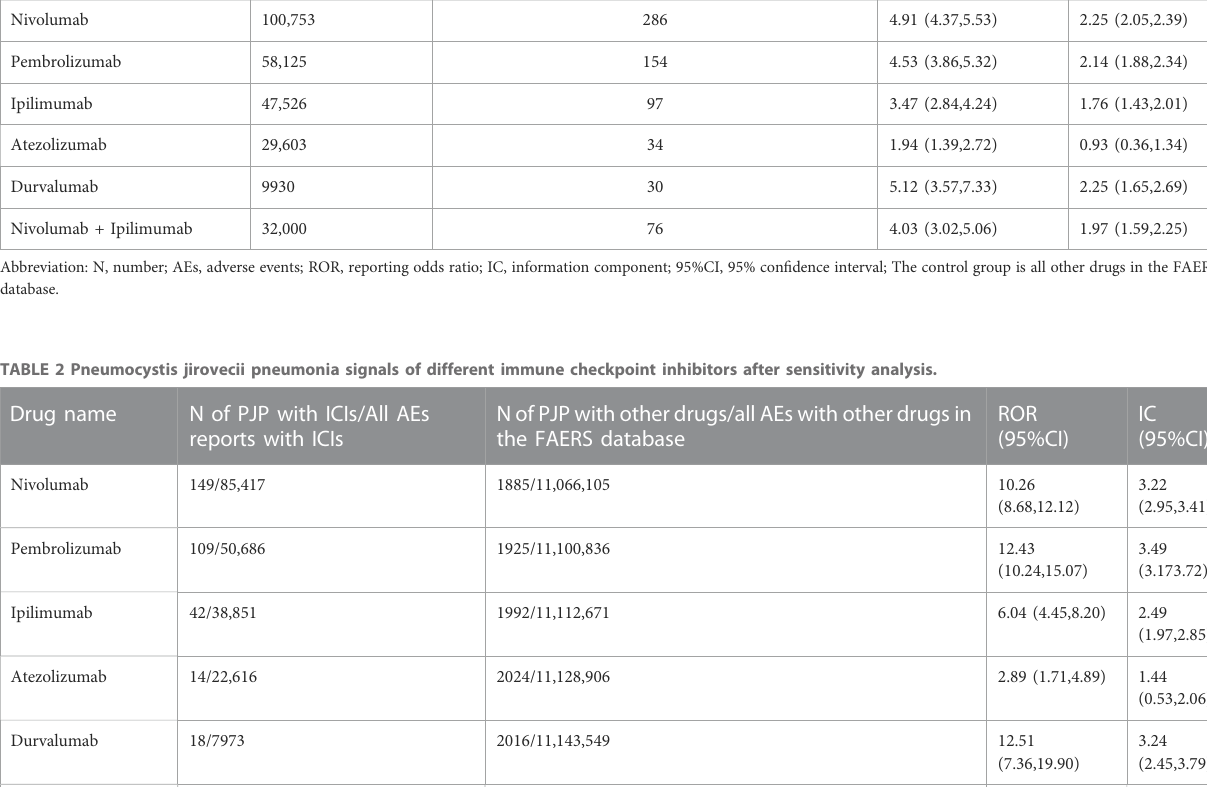
TABLE 1 Pneumocystis jirovecii pneumonia signals of different immune checkpoint inhibitors (Primary analysis). Drug name